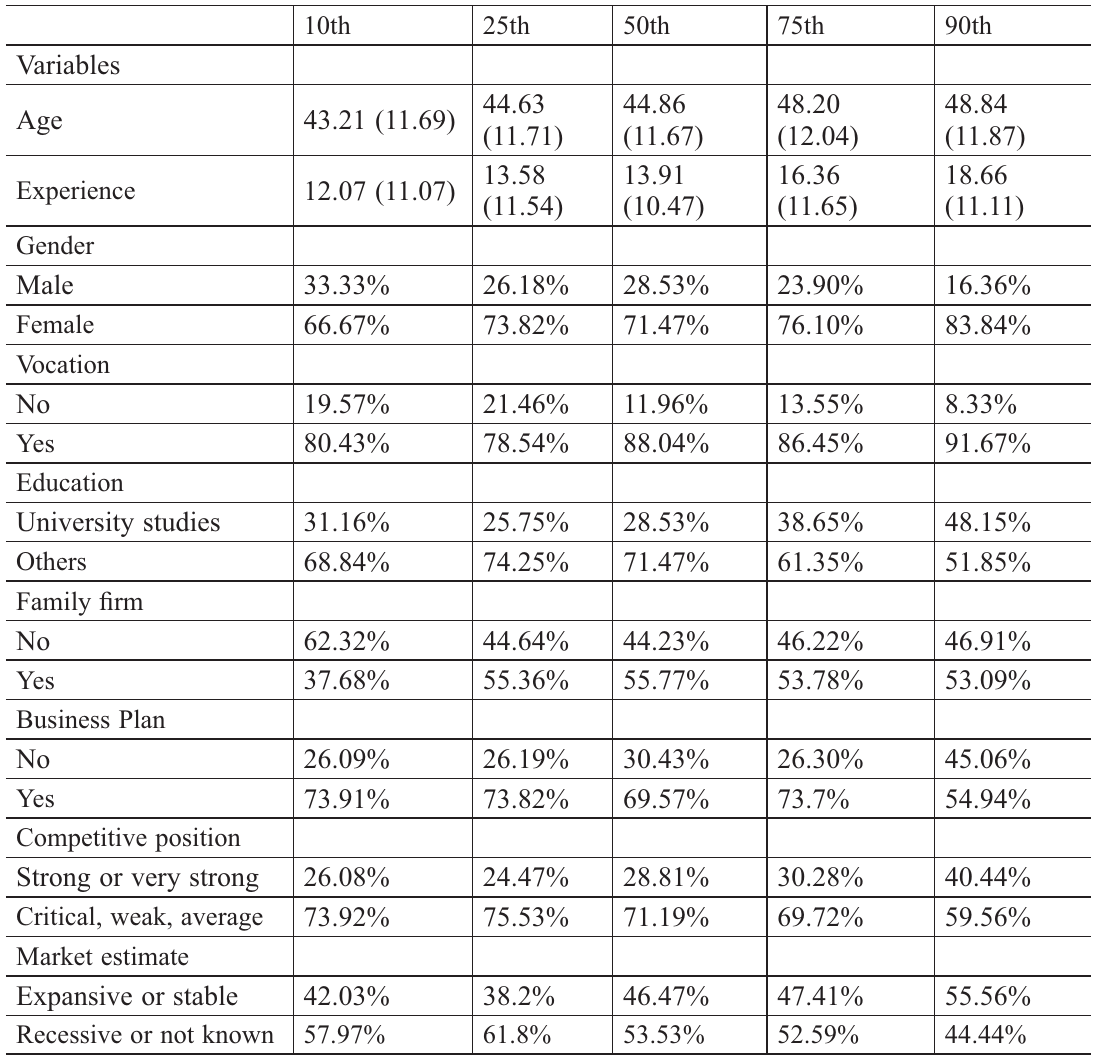
Table 4. Quartile averages for key